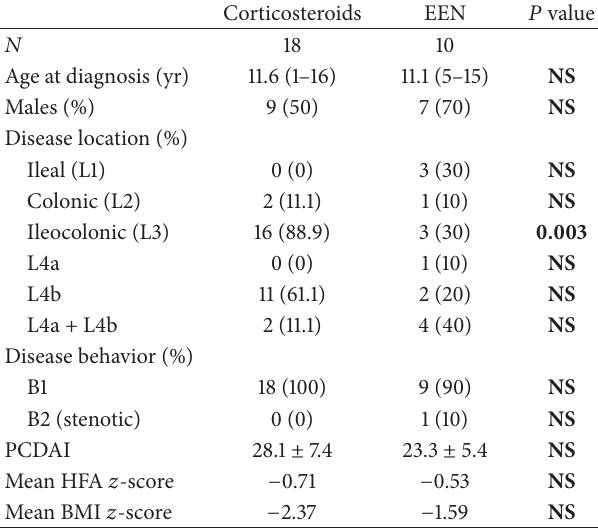
Table 1: Baseline characteristics of the study